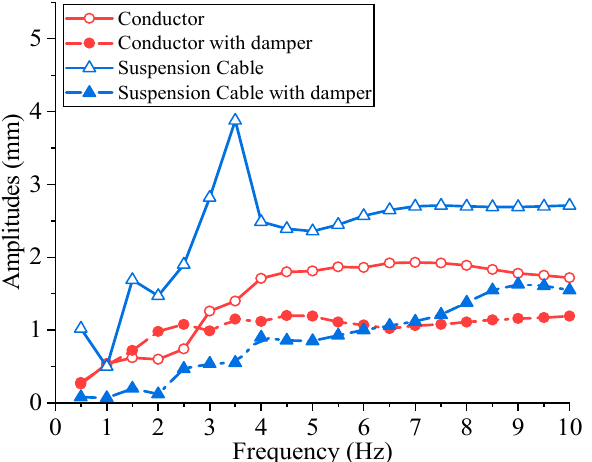
Figure 26. Amplitudes of long-span CRS (VIV occurs both in conductor and cable). In summary, the installation of dampers had an effect on the vibration characteristics of a long-span CRS. Additionally, dampers in the conductor and suspension cables signif- icantly reduce amplitudes, and the effect increases with frequency. Accordingly, the in- stallation of dampers on both conductor and suspension cables was effective and essential to protect the structure from the danger of VIV. The above discussion provided the preliminary basis for the design of protective measures of long-span CRS. Attaching dampers to the conductor and suspension cable was a practical protective measurement regarding VIV of long-span CRS. For suspension cables, the maximum amplitude occurred in a lower frequency band, which needs more attention. For the conductor, the resonance frequency band of the conductor and suspen- sion cable should be of concern because of the larger dynamic bending strain. Moreover, the installation of dampers had an effect on the vibration characteristics of long-span CRS. Accordingly, installing dampers on both conductor and suspension cables was effective and necessary to protect the structure from the danger of VIV. 6. Conclusions This paper presented a study on the wind-induced response of a long-span cross- rope suspension transmission power line with a tension insulator. The following corre- sponding conclusions were summarized. Assembly modeling of long-span CRS is one of the major topics discussed in this paper. Based on the approximate parabola shape function and finite element method, de- formed shapes of each substructure by gravity were calculated and assembled into a full structural system; The increase in wind speed resulted in significant changes in the tensile force and horizontal displacement of the structure. The results showed that horizontal displacement of conductor and tensile force of suspension cable increased with wind speed and number of spans. These results provide the basis for the actual engineering design of wind re- sistance performance of multi-span CRS; The increase in ice thickness resulted in an increase in the tensile force of suspension and cable. Moreover, the longer span length of the conductor induced a larger windward projected area of the conductor and thus larger tensile force in the suspension cable. On the other hand, horizontal displacement of the conductor increased firstly and then re- duced with ice thickness. The reason for this phenomenon was the combined action of increased wind load and tensile force of conductor induced by ice thickness; The VIV of long-span CRS and the effect of dampers were studied in the FE model. For the conductor, the increase in amplitude was majorly influenced by the equivalent lift force and dissipating power of the conductor, which led the amplitude to firstly increase and then decrease with frequency. For the cable, amplitude increased with frequency ex-